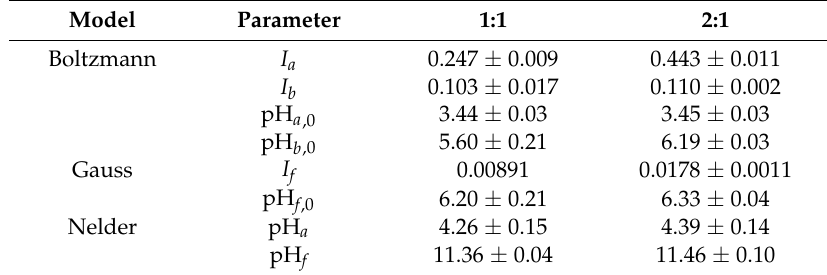
Table 2. Characteristics observed from 16-DSA-probed HSA in I abf and h − 1 / h 0 curves a .